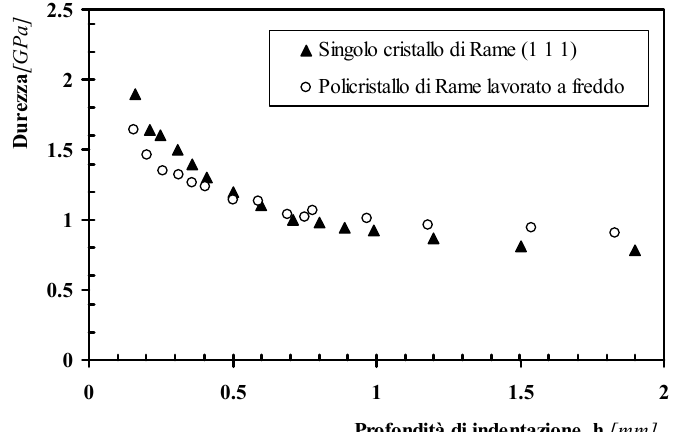
Figura 1: Dipendenza della durezza, misurata mediante una punta Berkovich, dalla profondità di indentazione di un singolo cristallo di rame e di un agglomerato policristallino di rame lavorato a freddo [4]. Figure 1: Relationship between Berkovich hardness and indentation depth in a single crystal as well as in a cold-rolled polycrystal of copper